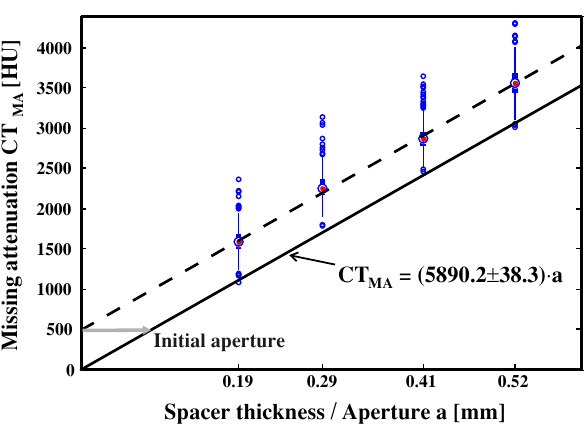
Figure 4. Calibration based on a total of 380 points at each spacer in order to apply the missing attenuation method. The circles with the red dot represent the medians for every spacer while smaller circles without dot are outliers. The thin and thick blue lines show 25% confidence intervals and 75%, respectively. The dashed line corre- sponds to the regression line of all calibration points. The solid line corresponds to the adjusted regression line used for further aperture calculations by neglecting an apparent aperture (0.08mm) caused by the fracture roughness (after Huo et al., 2016).